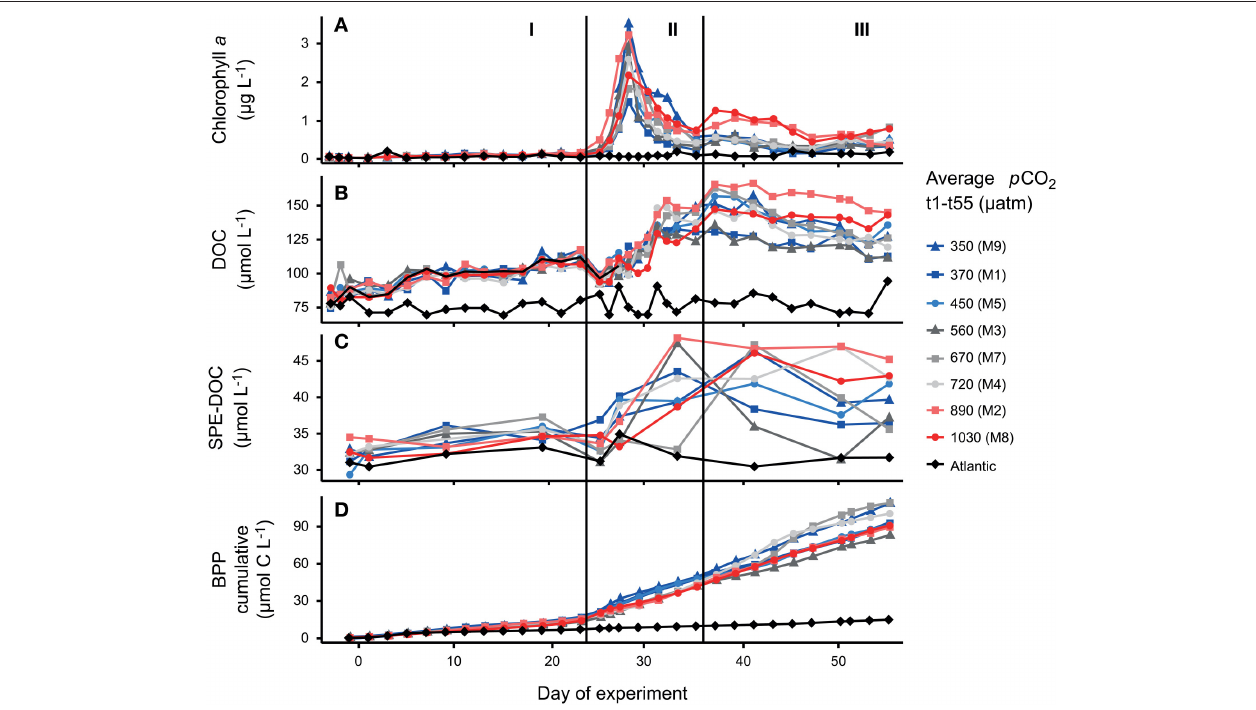
FIGURE 2 | Time series data from the mesocosm units and surrounding Atlantic water. Colors display the average p CO 2 value from day 1 to day 55. Concentration of (A) chlorophyll a , (B) dissolved organic carbon (DOC), (C) SPE-DOC as measure of the solid-phase extractable component in dissolved organic matter, and ( D ) cumulative bacterial protein production over experiment